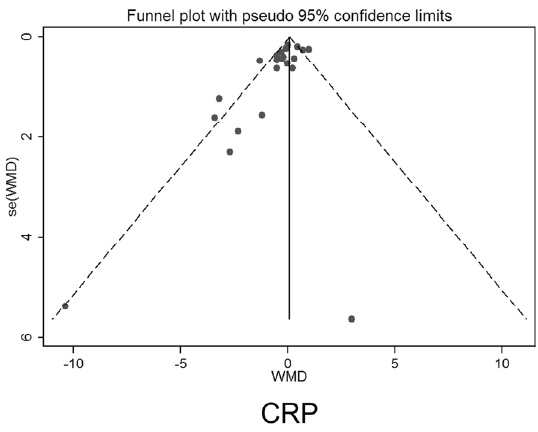
Figure 3. Funnel plots for testing publication bias.